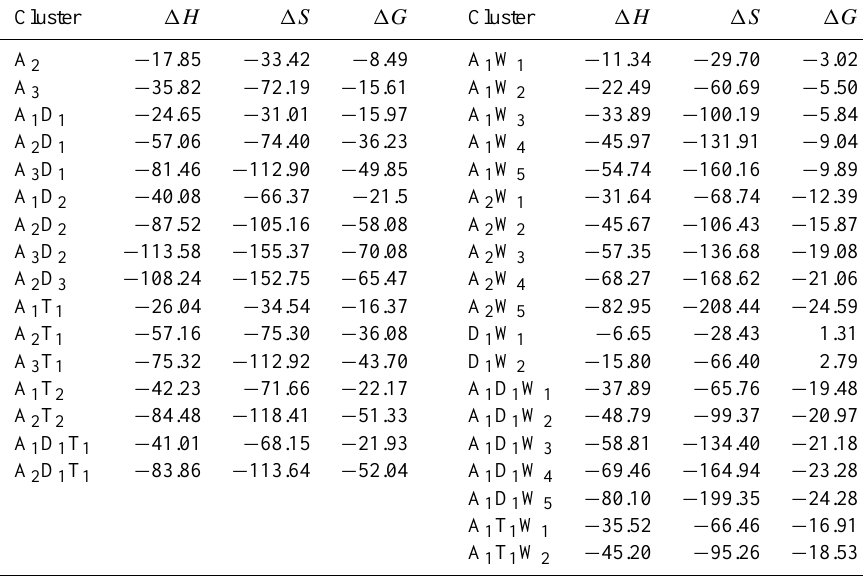
Table 1. Formation enthalpies 1H and entropies 1S , calculated at 298 K, and the corresponding Gibbs free energies 1G at T = 280 K. The values of 1H and 1G are given in [kcal mol − 1 ], and 1S in [cal mol − 1 K − 1 ].